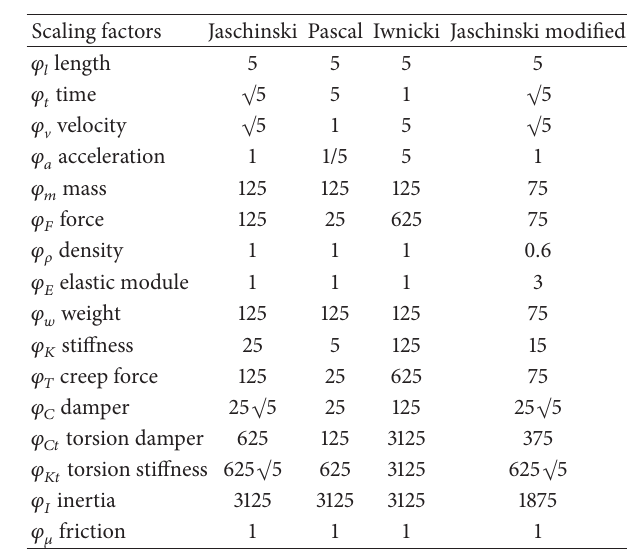
Table 1: Comparing of 1: 5 scaled roller rig approaches [30].